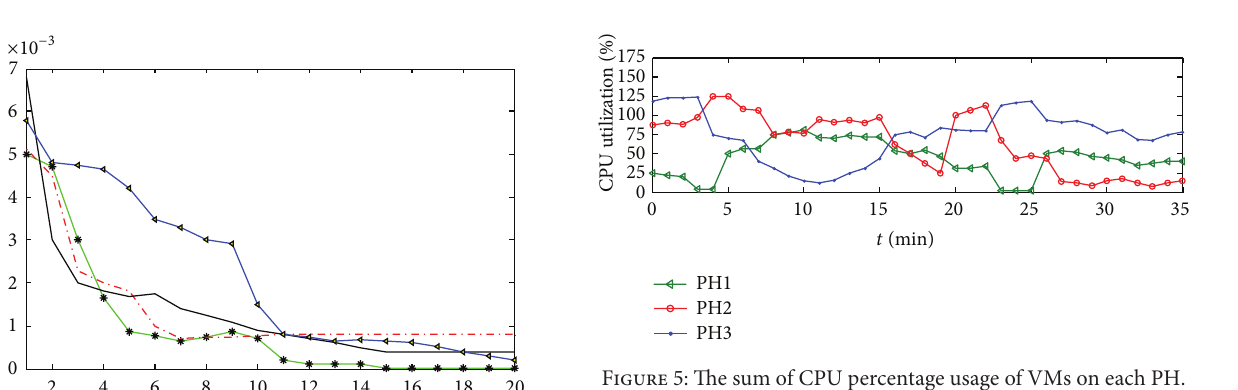
Figure 3: Flow diagram of BSPSO.